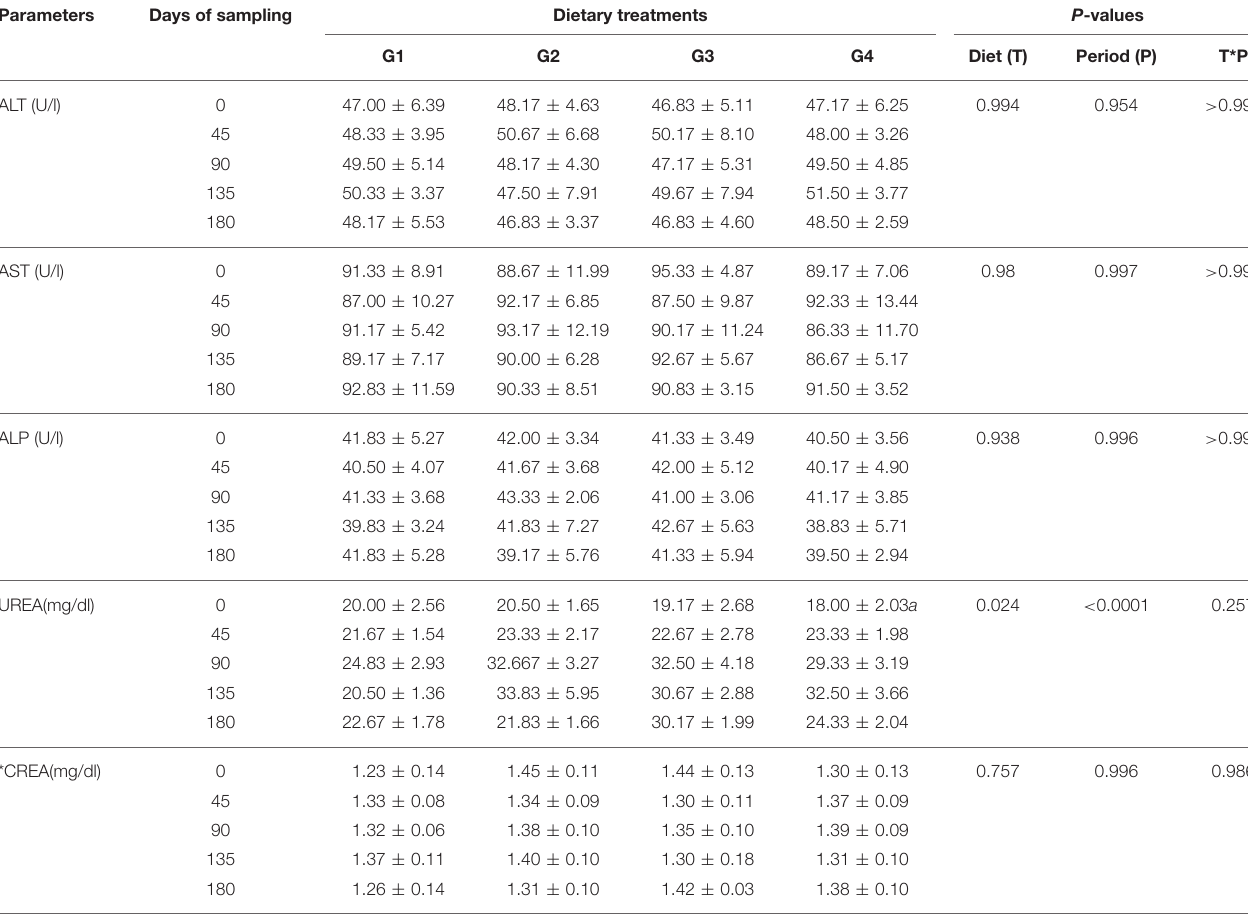
TABLE 4 | Effect of dietary Bt and CP4EPSPS proteins on Serum biochemical response and enzymes activities of female rabbits.